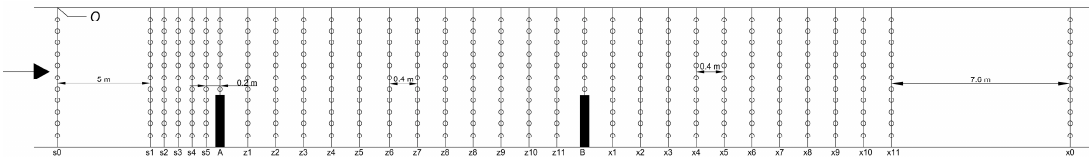
Figure 5. Distribution of measured cross-sections and points.